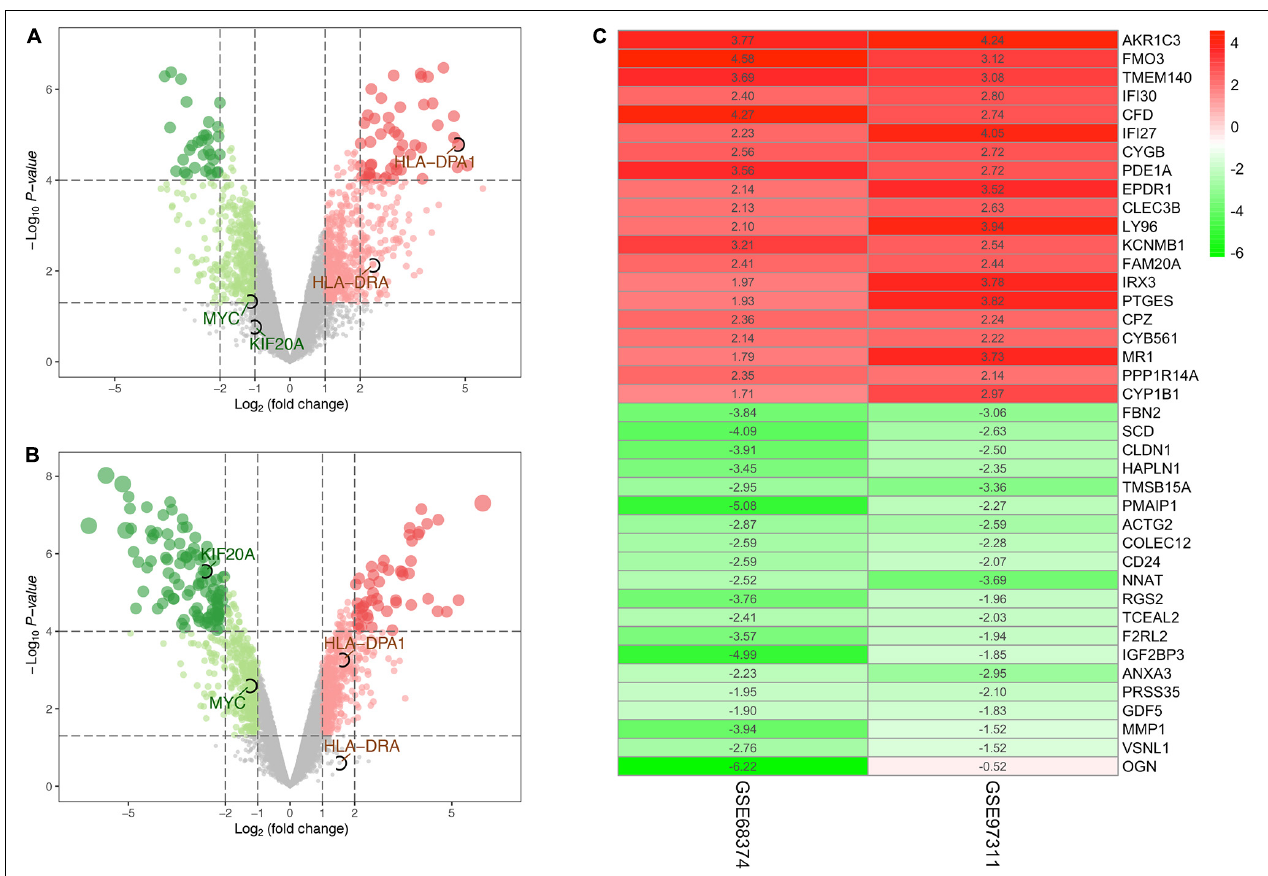
FIGURE 1 | Identification of differentially expressed genes (DEGs). (A) Volcano plot of DEGs for dataset GSE68374. (B) Volcano plot of DEGs for dataset GSE97311. (C) The heatmap of the top 40 (20 up-regulated and 20 down-regulated) DEGs according to P -value identified by the RRA method. The number in the heat map represents log FC. The gradual color ranging from red to green indicates the changing process from up- to down-regulation. Genes circle by black ellipses are the hub genes screened out by subsequent